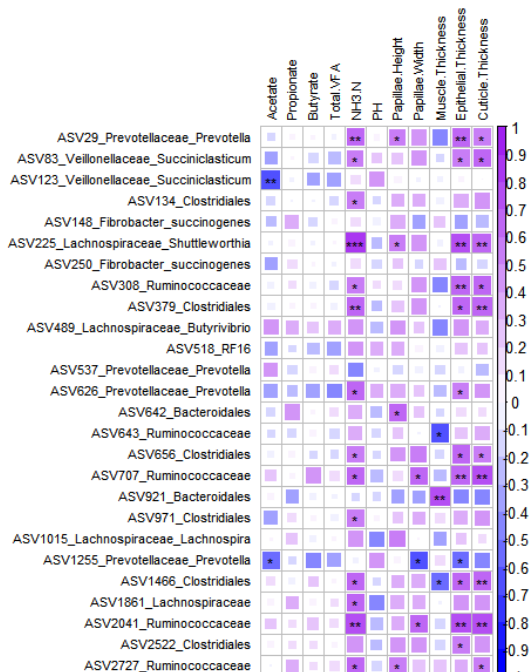
Figure 5. The associations between signature bacteria and rumen phenotypes. The colors of the squares range from blue to purple to indicate negative (closer to −1) to positive (closer to 1) correla- tions. The degree of significance is indicated by the symbol *, 0.01 < * p < 0.05; 0.001< ** p < 0.01; *** p < 0.001.